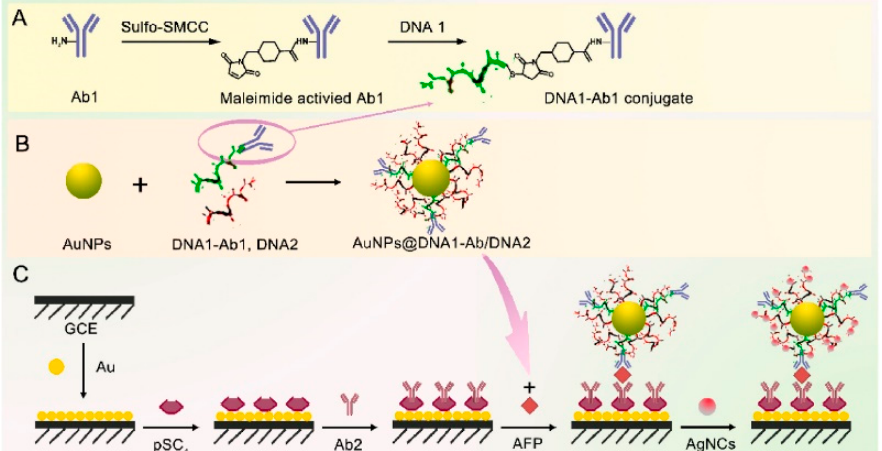
Figure 9. Schematic illustration of the preparation procedure for the sandwich-type electrochemical immunosensor. ( A ) The DNA1-Ab1 conjugate. ( B ) The formation of AuNPs@DNA1-Ab1/DNA2. ( C ) The principle of the proposed immunesensor [93]. Copyright (2023)